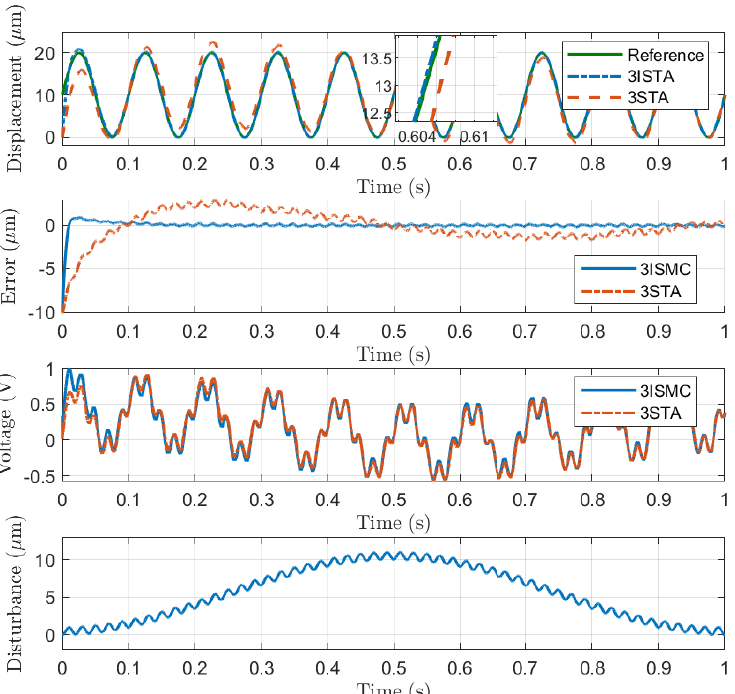
Figure 7. Simulation results of 10Hz sinusoidal trajectory tracking with external disturbance. ( a ) Position